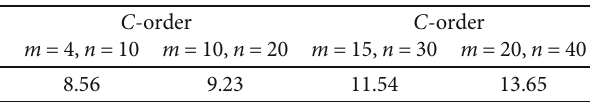
Table 2: C -order of the presented method for Example 6. C